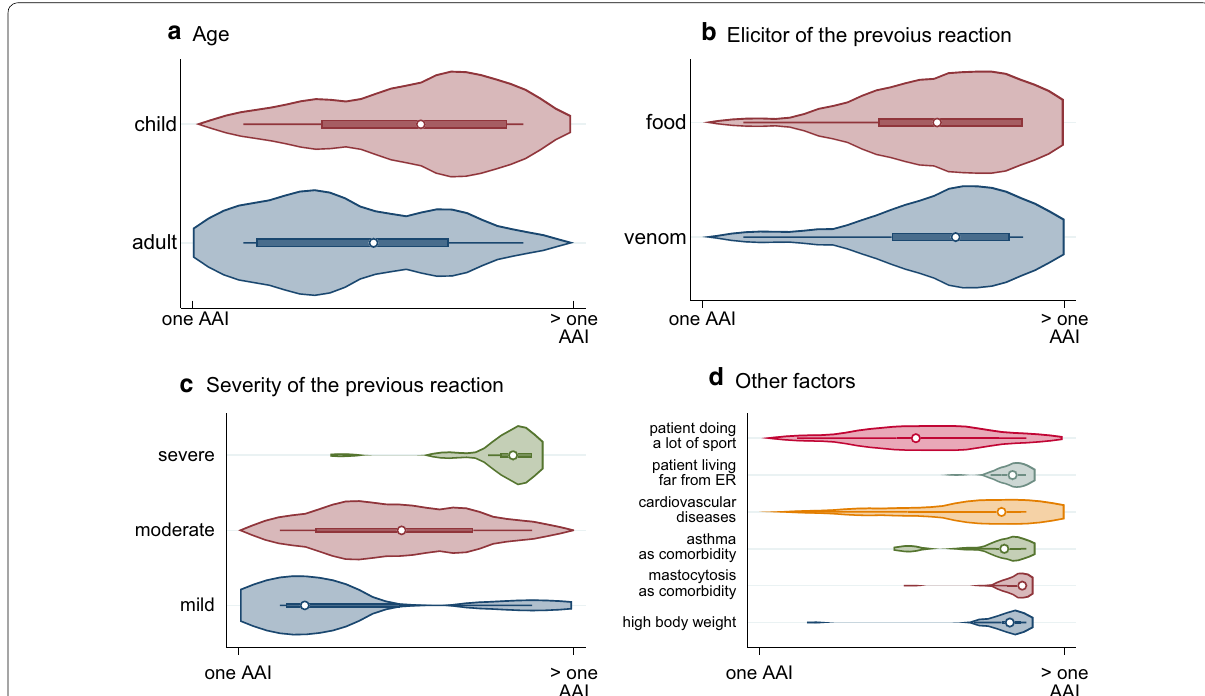
Fig. 3 Factors influencing the AAI prescription behavior. The violin plots indicate if the given factor: age ( a ), elicitor ( b ), severity ( c ) or other factors ( d ) would influence the experts to prescribe one (left end of the scale) or more than one (right end of the scale) autoinjectors